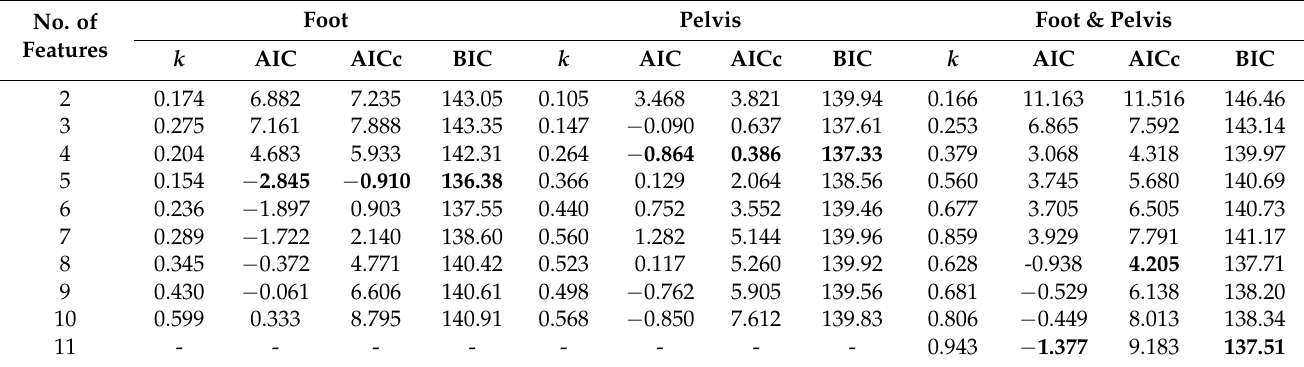
Figure 5. Optimal parameter k tuning for ridge regression: ( a ) foot, ( b ) pelvis, and ( c ) foot and pelvis. The optimal k for each model was chosen when the GCV was minimum ( k = 0.154, 0.264, and 0.943 for foot, pelvis, and foot & pelvis, respectively). Table 6. AIC/AICc/BIC Values for Model Selection.